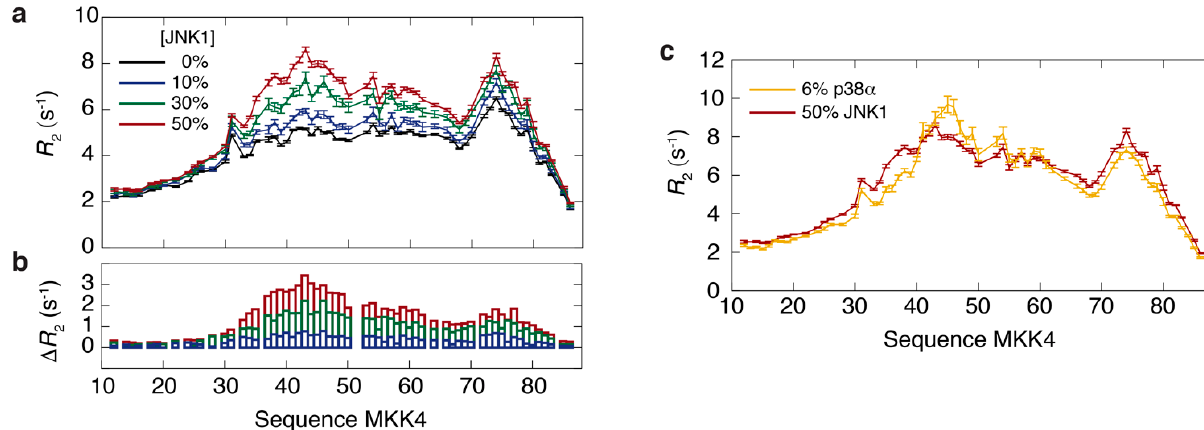
Figure 3. ( a , b ) 15 N R 2 rates in MKK4 measured as function of different molar ratios of JNK1 (0%, 10%, 30% and 50%). Panel ( b ) shows the difference in the rates compared to the free form of MKK4. ( c ) Comparison of 15 N R 2 rates in MKK4 in the presence of JNK1 (50% molar ratio, red, this work) and p38 α (6% molar ratio, yellow, adapted from ref. [35]).